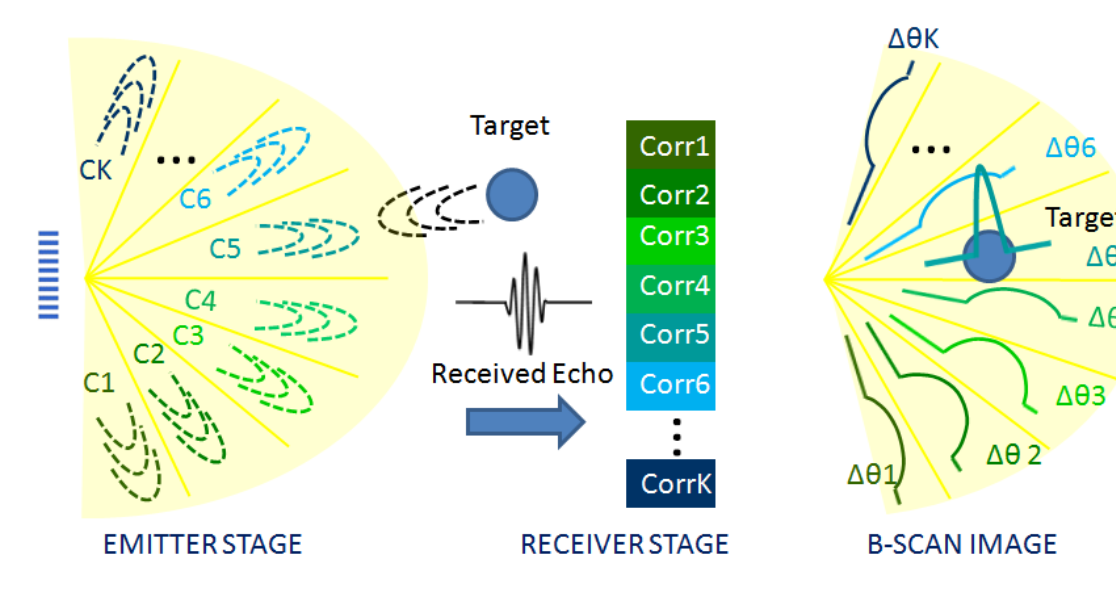
Figure 5. Encoded PA proposal